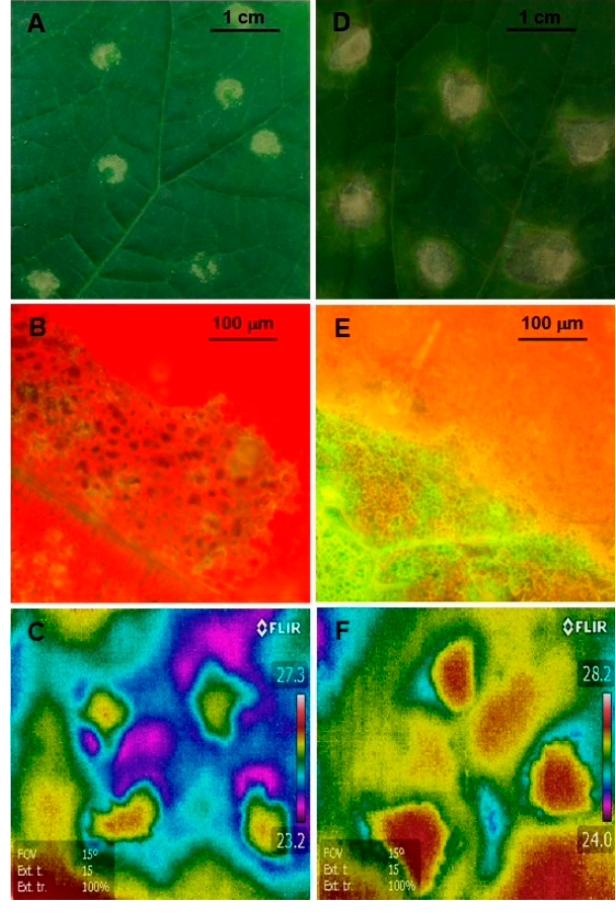
Figure 1. Pseudomonas syringae pv lachrymans ( Psl ) infection development in the 3rd leaves. ( A,D ) Macroscopic symptoms of Psl infection 2 dai after inoculation ( A ) and 7 dai ( D ). ( B , E ) Chlorophyll autofluorescence 2 dai ( B ) and 7 dai ( E ). ( C , F ) Thermal imaging of infection development 2 dai ( C ) and 7 dai ( F ). Images are representative for at least three experiments, using a minimum of six plants.